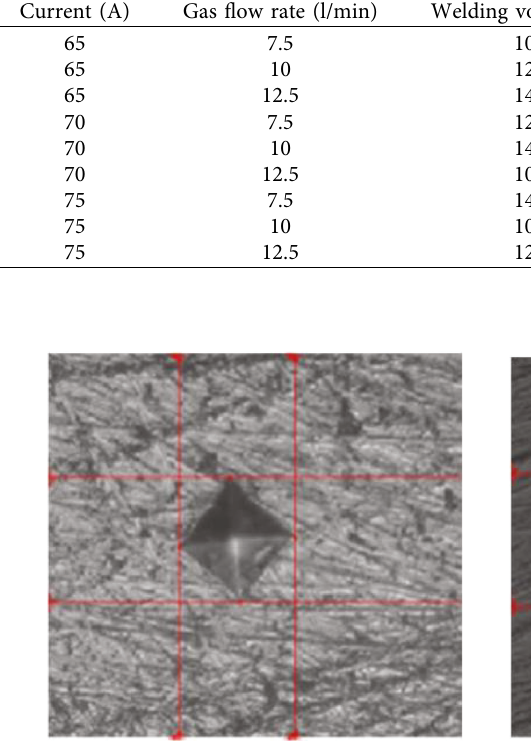
Figure 4: Visuals of the microhardness